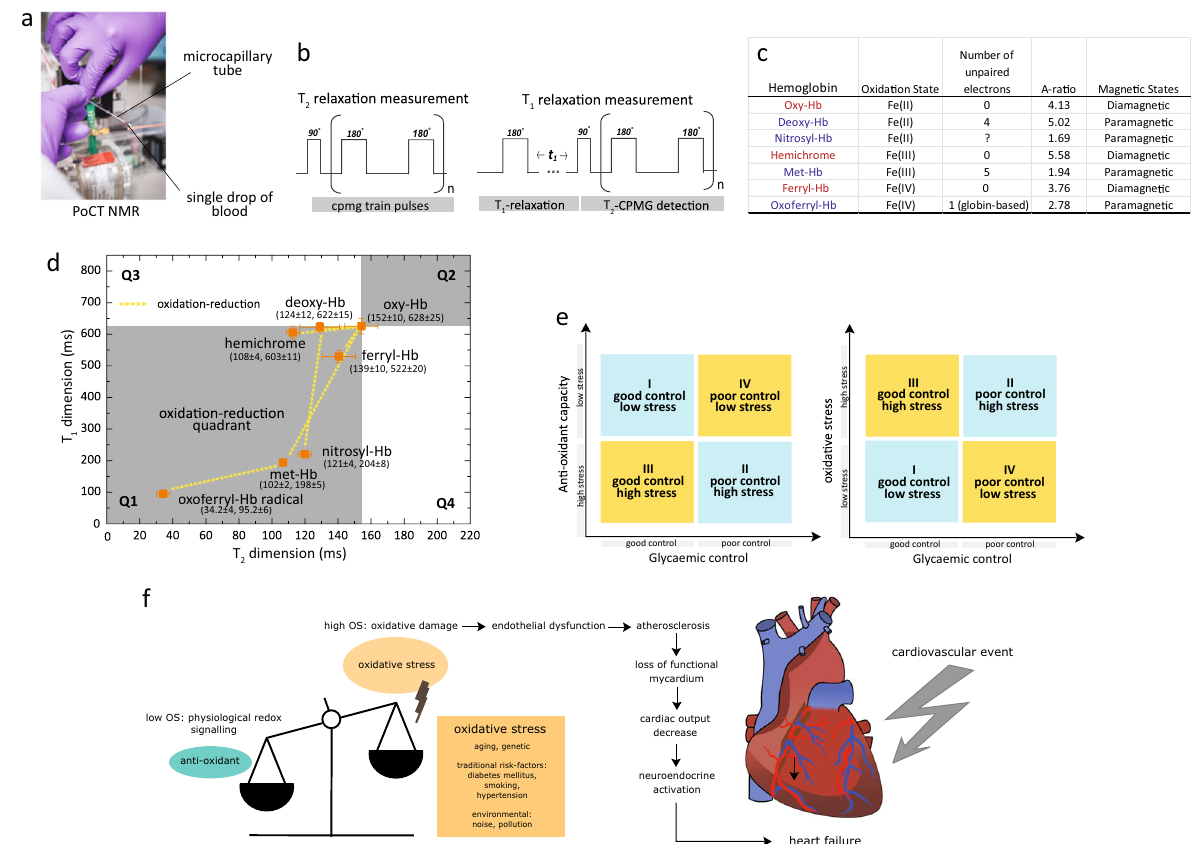
Fig. 1 Functional sub-phenotyping of oxidative stress with micro MR analysis approach. a The developed bench-top sized micro MR system consists of a commercial console, detection circuit coil mounted on a micro stage, and a palm-sized 0.5 T permanent magnet. The microcapillary tube which contains a single drop of blood is slotted into the radio-frequency probe for micro MR analysis. The read-out completes in <5 min. b The rf pulse sequences used were standard CPMG pulse sequence and standard inversion-recovery experiment (with CPMG detection) for the T 2 relaxations, and T 1 relaxations measurements, respectively. In order to obtain high signal-to-noise ratio under a relatively inhomogeneous magnetic environment, an array of echoes (a few thousands) within a very short echo interval (in the order of μ s) were used to acquire spin-echoes from <4 μ L sample volume of packed RBCs or plasma. c Redox reaction of the iron-heme in various oxidation states: Fe 2 + , Fe 3 + , Fe 4 + , and globin-radical Fe 4 + , which were chemically induced in in vitro environment (Methods Online). The hemoglobins were in two possible magnetic states: diamagnetic (red) and paramagnetic state (blue). d Various redox states of hemoglobin mapped out using the proposed T 1 – T 2 magnetic state diagram. The coordinates (in ms) were oxy-Hb ( T 2 = 152 ± 10, T 1 = 628 ± 25), deoxy-Hb ( T 2 = 124 ± 12, T 1 = 622 ± 15), met-Hb ( T 2 = 102 ± 2, T 1 = 198 ± 5), ferryl Hb ( T 2 = 139 ± 10, T 1 = 522 ± 20), oxo ferryl-Hb ( T 2 = 34.2 ± 4, T 1 = 95.2 ± 6), nitrosyl-Hb ( T 2 = 121 ± 4, T 1 = 204 ± 8), and hemichrome ( T 2 = 108 ± 4, T 1 = 603 ± 11). Three different samplings were taken from the same donor, and the results were reported as mean ± standard error measurement. The data is represented by box-plot format. e A quadrant chart of diabetic subject strati fi ed into subgroups based on their oxidative status (e.g., antioxidant capacity (left) and oxidative stress (right), in which the oxidative stress here includes nitrosative stress and peroxidative stress), in association with their glycemic index (e.g., HbA 1c ). f Relationship between elevation of oxidative stress and development of DM-related complications (e.g., cardiovascular